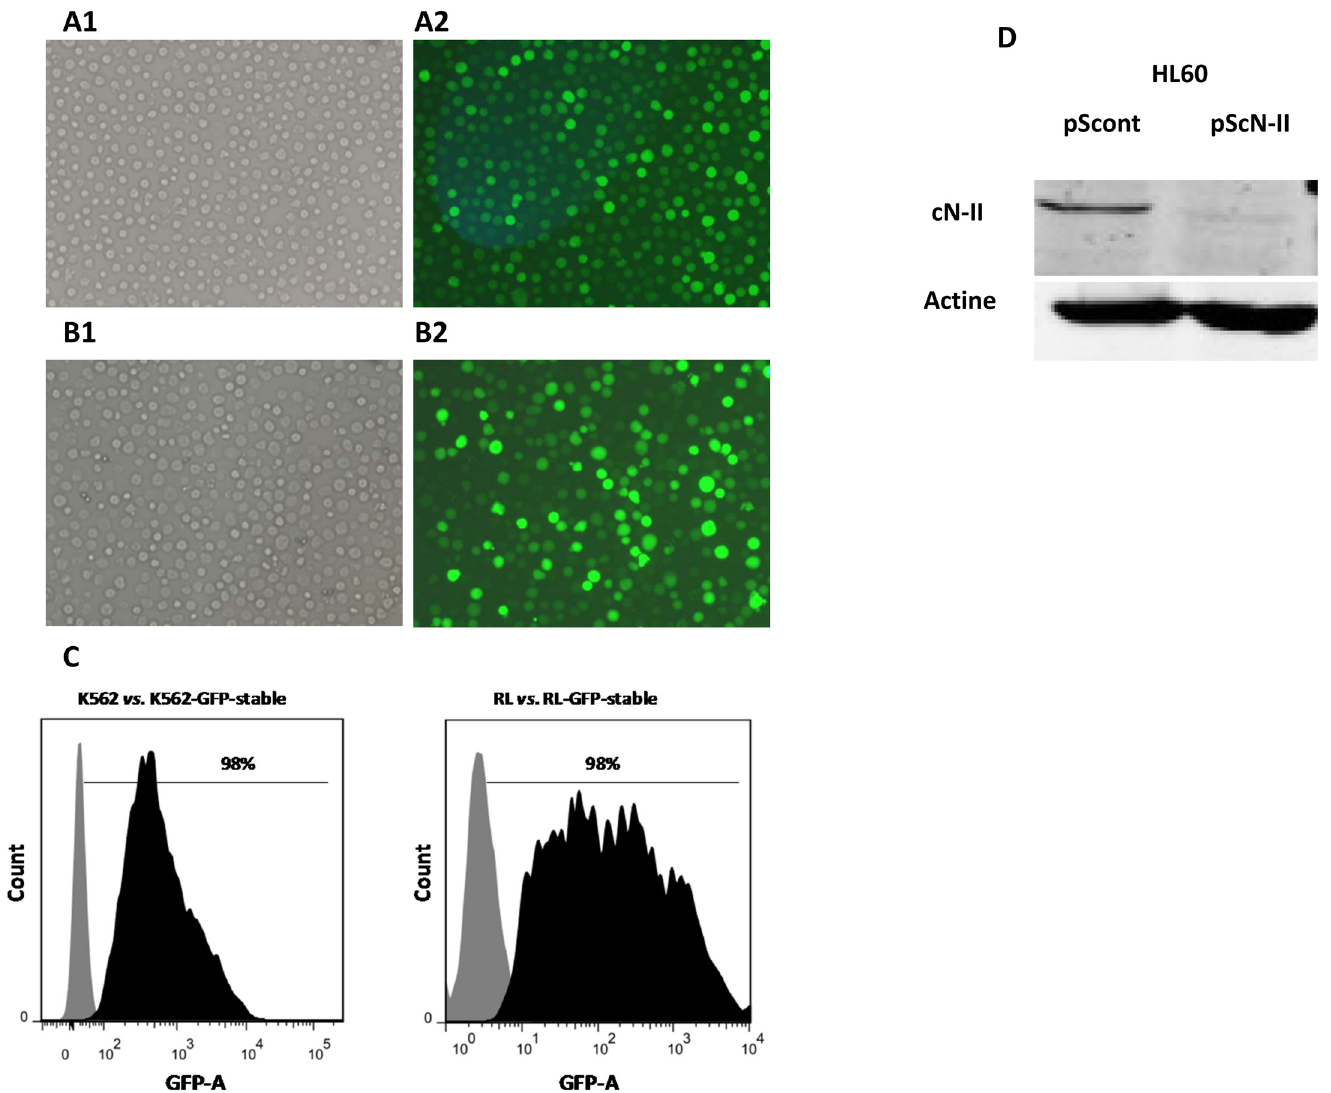
Fig 7. Production of stably transfected K562, RL and HL60 cells by sonoporation. K562 and RL cell lines were transfected with pEGFP-C1 plasmid and cultured in selection medium containing 1.2 and 1.5 mg/ml of G418, respectively. The microscopy pictures (objective 10×) correspond to light transmission (A1 and B1) and fluorescence images of RL-pEGFP-C1 (A2) and K562-pEGFP-C1 (B2) stable clones. (C) The GFP channel histograms obtained from flow cytometry are shown. Grey indicates non-transfected cell lines and black indicates GFP-transfected cell lines. Flow cytometry analysis revealed 98% GFP positive cells in the stable clones. (D) HL-60 cell line transfected with expression vectors coding for shRNA against cN-II (pScN-II) and control sequence (pScont) were selected with continuous exposure to 1 mg/ml (HL60-pScN-II and HL60-pScont cells) of G418. Western blot analysis clearly showed strong inhibition of cN-II expression in HL60-pScN-II cells compared with cells expressing a non-silencing shRNA. Results are representative of three independent western blot